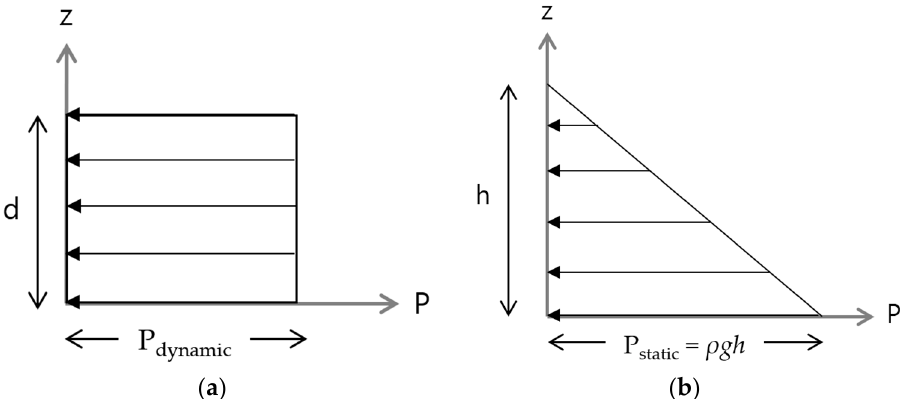
Figure 9. The distribution of pressure applied to the barrier surface: ( a ) dynamic debris-flow cluster (v ≠ 0), and ( b ) static debris-flow cluster (v = 0).